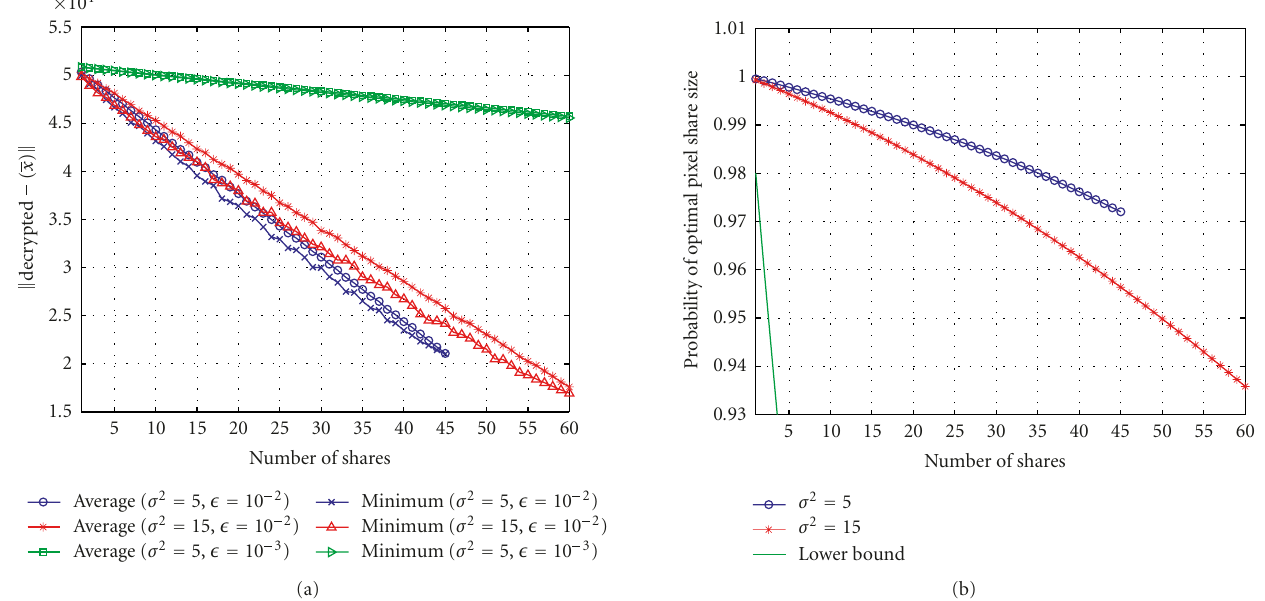
(cid:26) n u k − x (cid:5) as a function of the number of shares n ; (b) Pr { k = 0